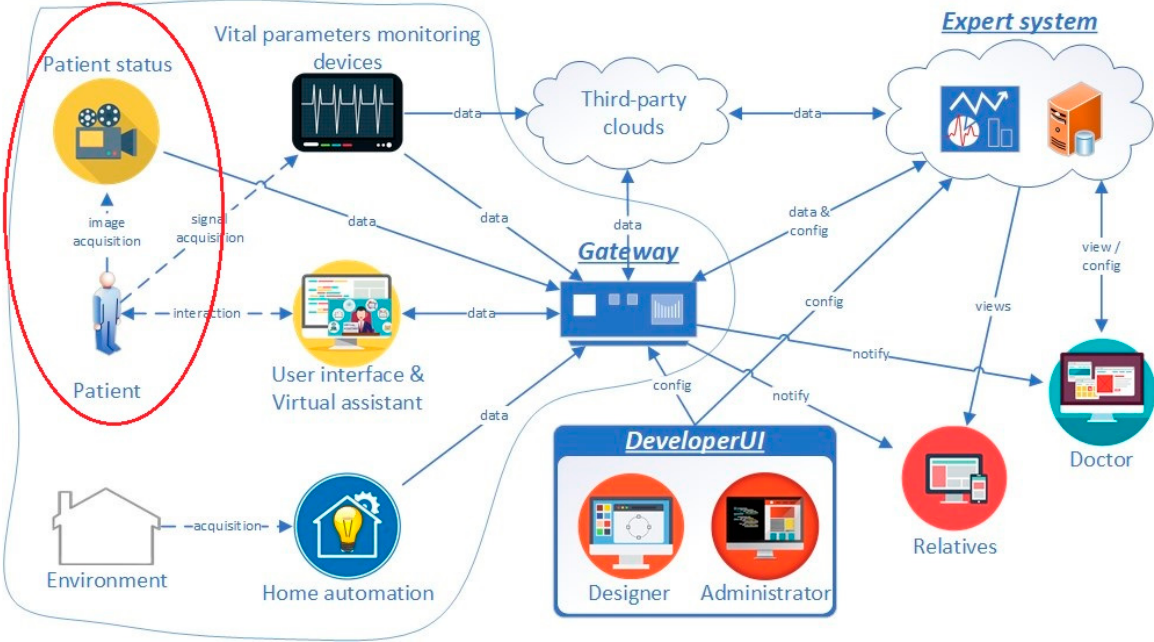
Figure 2. The human activity recognition module integrated in the SmartCare